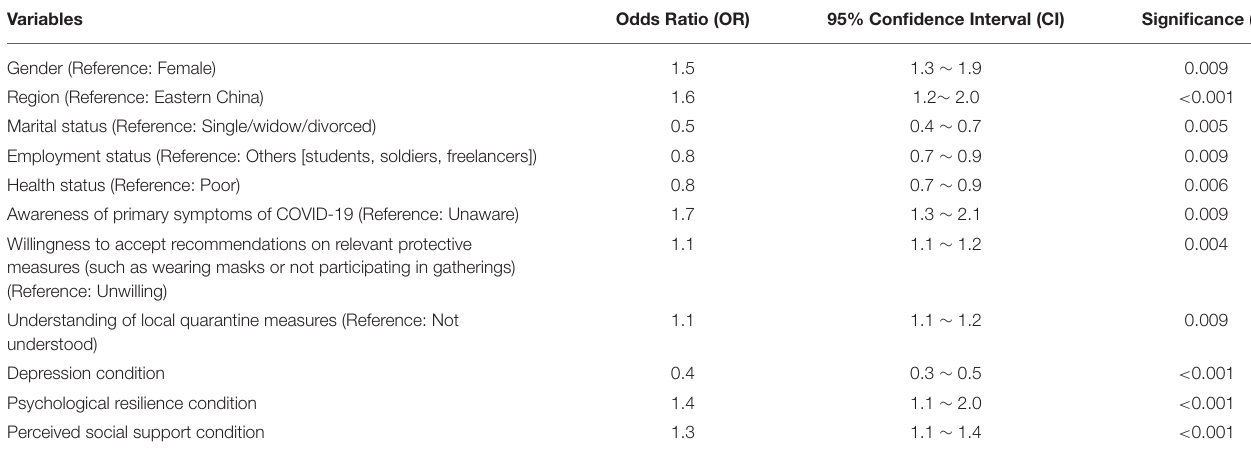
TABLE 3 | Results of the multivariable analyses for home quarantine among the Chinese residents.